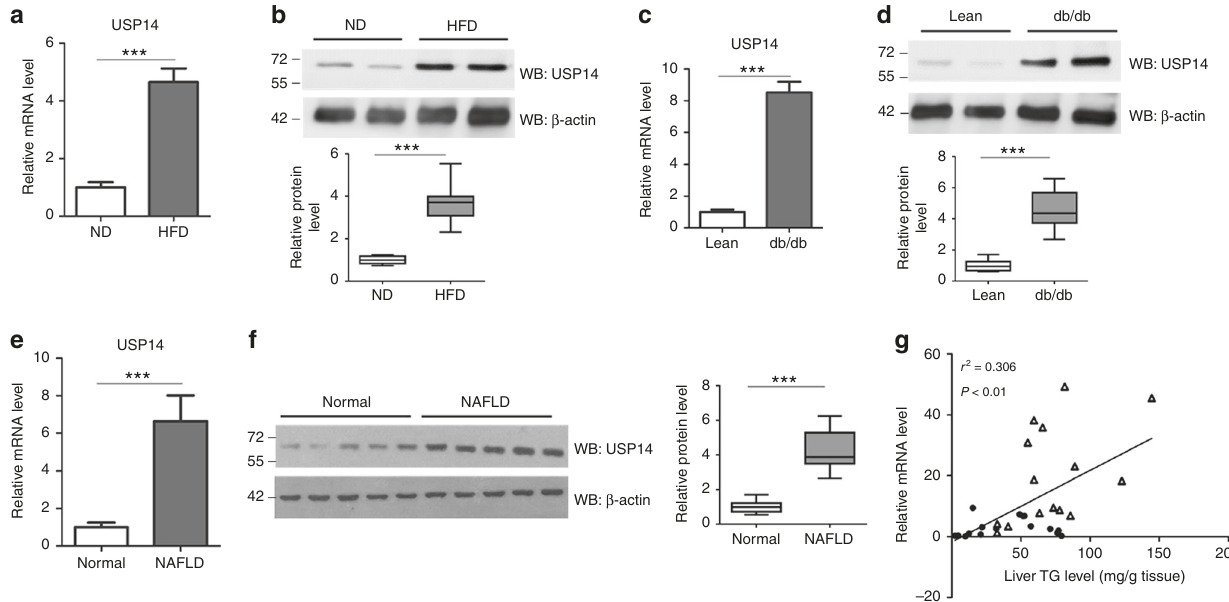
Fig. 1 Upregulation of USP14 in livers from obese mice. a – d Hepatic mRNA and protein levels of USP14 in HFD obese mice a , b and leptin receptor-de fi cient db/db mice c , d . ( n = 8 – 9 for each group). A representative western blot was shown and the quanti fi cation plot was based on scanning densitometry analysis using the Image J software (v 1.8.0). *** p < 0.001 versus indicated groups (Student ’ s t -test). The top and bottom whiskers in b , d are the largest and smallest value, bounds of box show the 25th or 75th percentiles, and center line corresponds to the median. e , f Relative mRNA and representative protein expression of USP14 in livers from NAFLD patients ( n = 15) and normal subjects ( n = 16). A representative western blot was shown with the quanti fi cation plot based on scanning densitometry analysis. *** p < 0.001 versus indicated groups (Student ’ s t -test). g Pearson R - and P -value for normalized USP14 mRNA levels versus TG content in human livers ( n = 31). Data are presented as mean ± SEM. *** p < 0.001